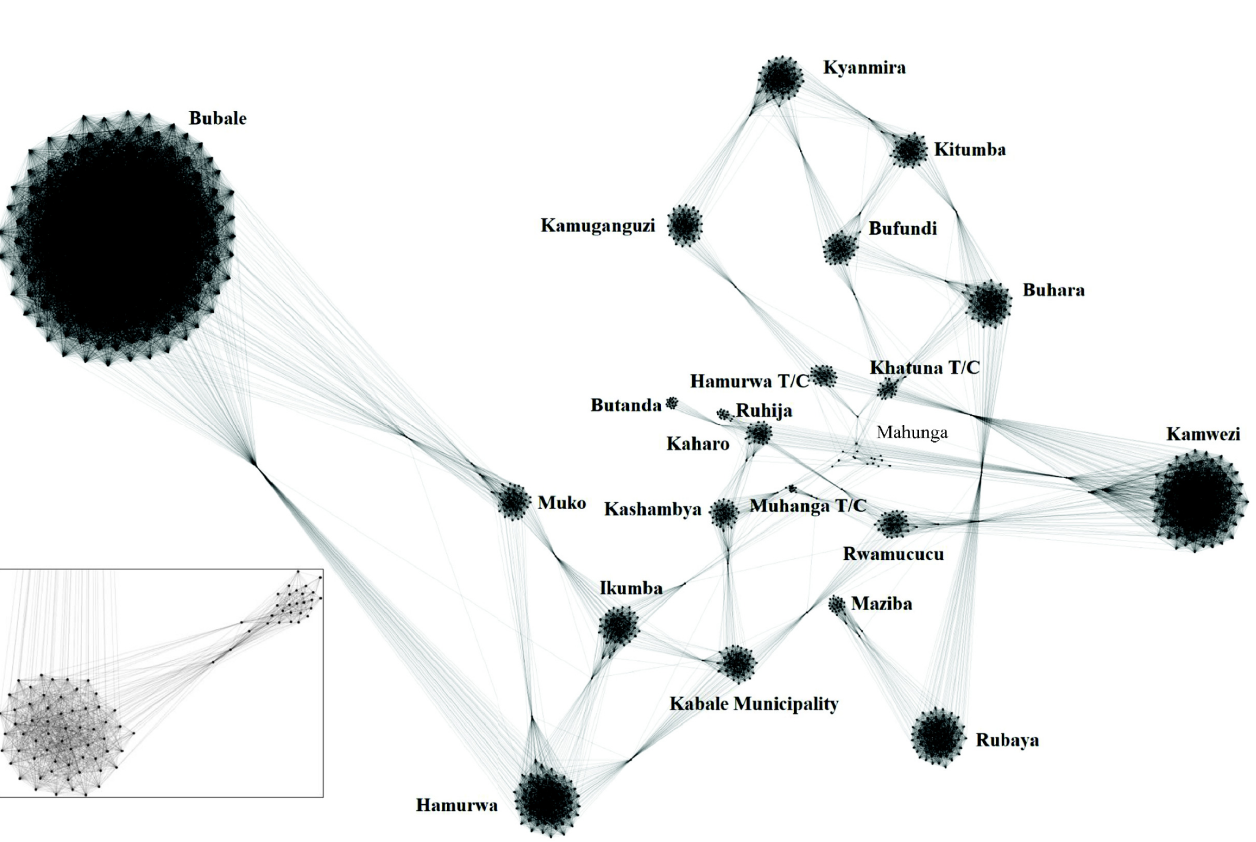
Fig 3. Overall structure of the network; dense circular groupings of black dots represent different locations. The inset shows a close-up of two such groupings, and one possible arrangement of links within and between them. Long black lines connect some locations, representing potential movement-related connections, and thus opportunities for mosquito-mediated transmission of RVFV between cows from different locations. The inset expands a small portion of the contact network showing the dense circular masses are made up of small black circles, each of which represents 20 cows and correspond to the nodes shown in the representative contact network. Likewise, the black lines among these nodes represent possible connections within and between locations in the inset.